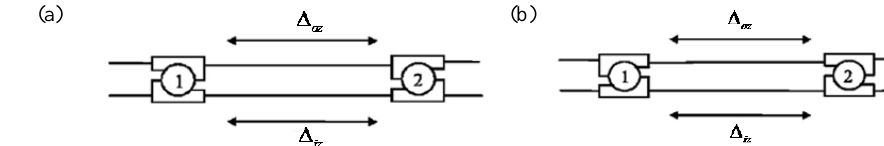
Figure 6. Bearing configuration. (a) O configuration (b) X configuration.